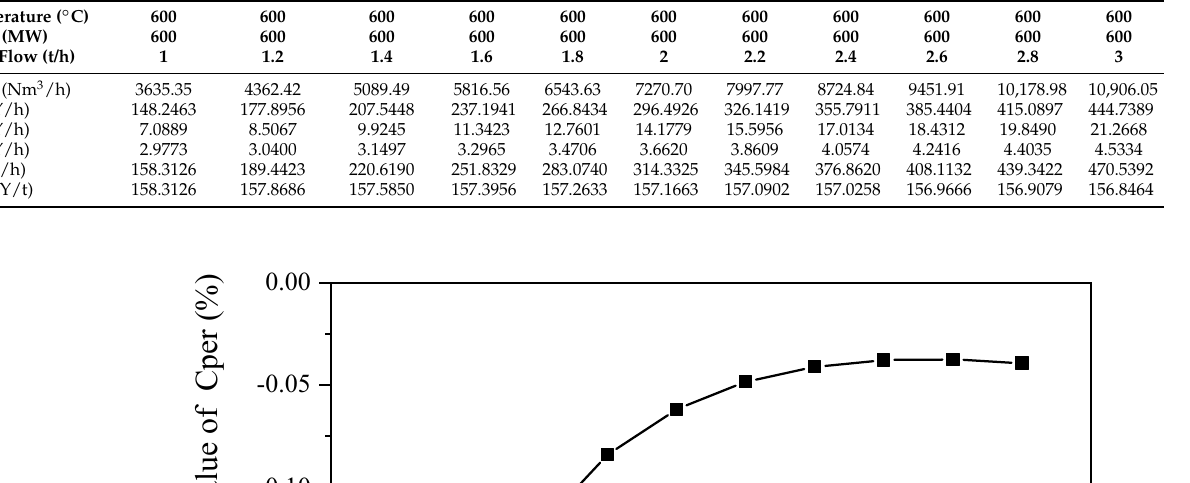
Table 3. Economic parameters under conditions where the concentrates had different handling capacities.